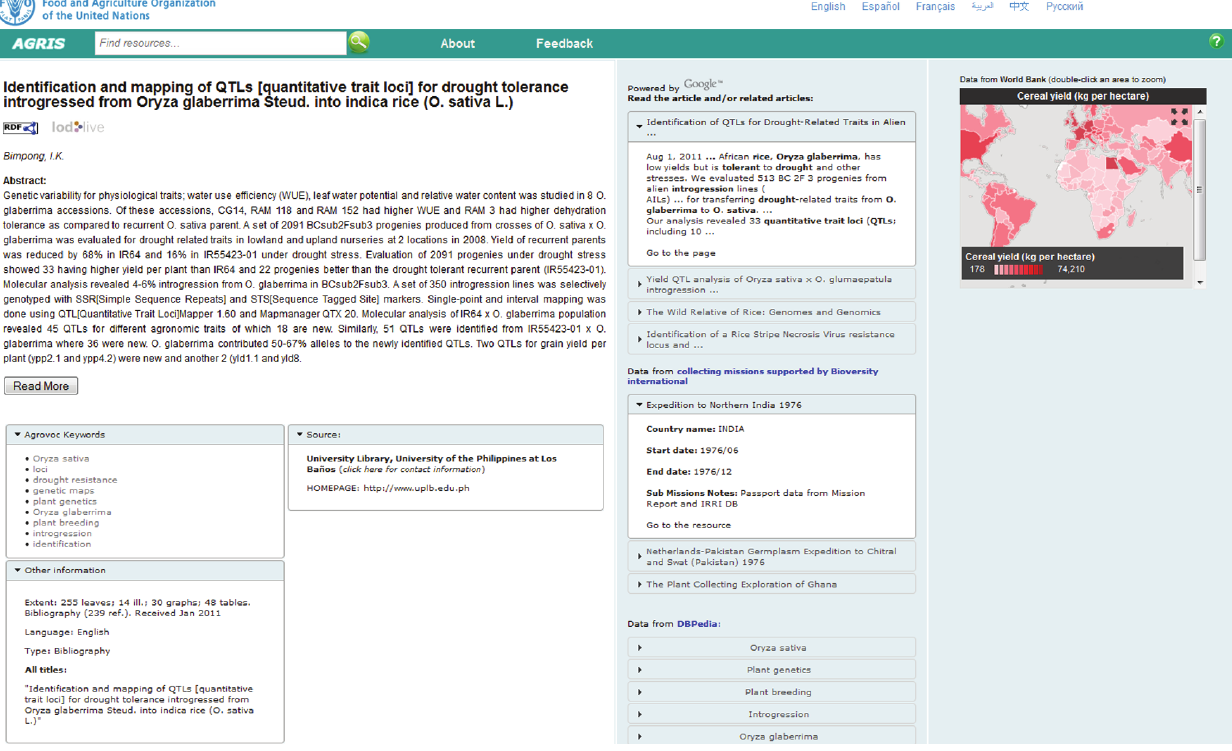
Figure 1. AGRIS mashup screenshot showing AGRIS bibliographic records pulling and visualising linked resources from external data